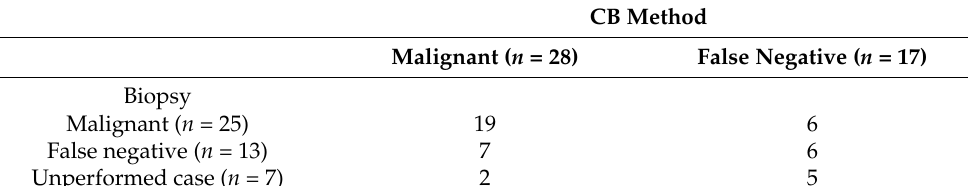
Table 4. Comparison of diagnosis using the cell block (CB) method and biopsy in malignant disease.